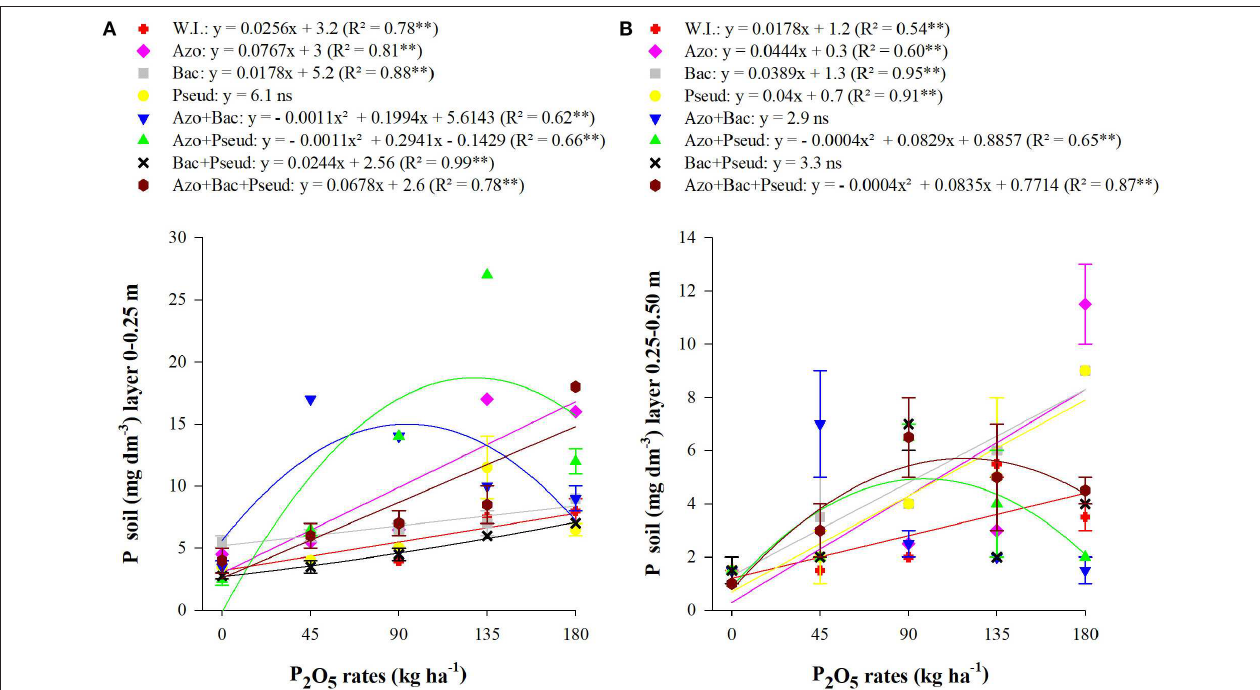
FIGURE 2 | Interactions between bacterial inoculations and P 2 O 5 doses for soil available P in the 0–0.25m (A) and 0.25–0.50m layers (B) . (Mean values ± standard deviation). ** and ns: significant at 1% at p < 0.01 and not significant, respectively. W.I., without inoculation; Azo, Azospirillum brasilense ; Bac, Bacillus subtilis ; Pseud, Pseudomonas fluorescens ; Azo + Bac, A. brasilense + B. subtilis ; Azo + Pseud, A. brasilense + P. fluorescens ; Bac + Pseud, B. subtilis + P. fluorescens ; Azo + Bac + Pseud, A. brasilense + B. subtilis + P. fluorescens .